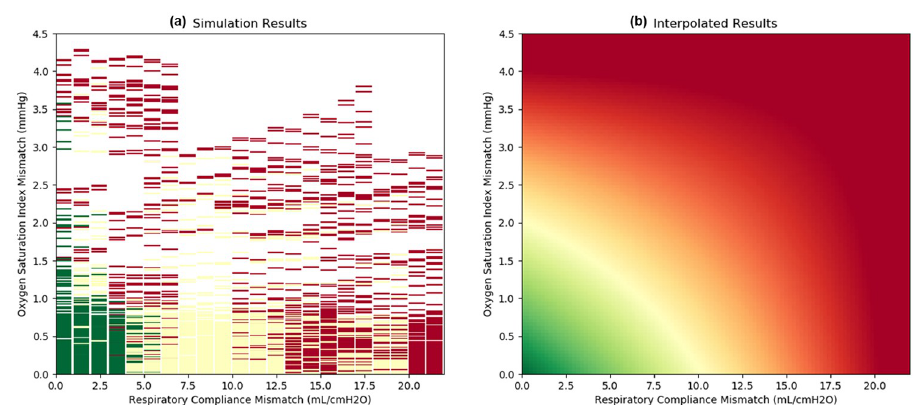
Fig 6. The simulations from Fig 4 were holistically taken into account to get a complete decision matrix. Outcomes were assigned a normalized value of green = 1, yellow = 0.5, and red = 0 to encode a z-axis as colors or color gradient. The resulting three-dimensional scatter plot (plot a) was used to produce an interpolated surface using the first-order bivariate B-spline method (plot b).